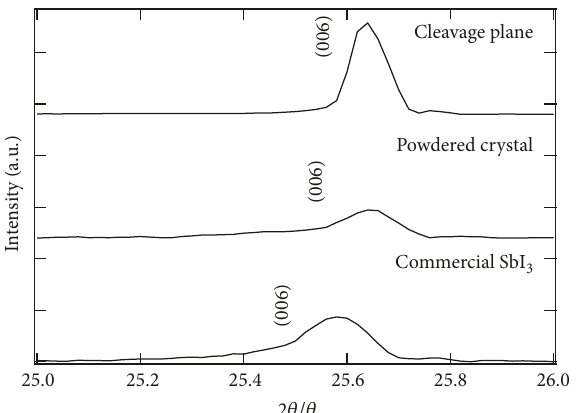
Figure 6: Magnification of the X-ray diffraction patterns in the region of the (006) reflection of SbI 3 .